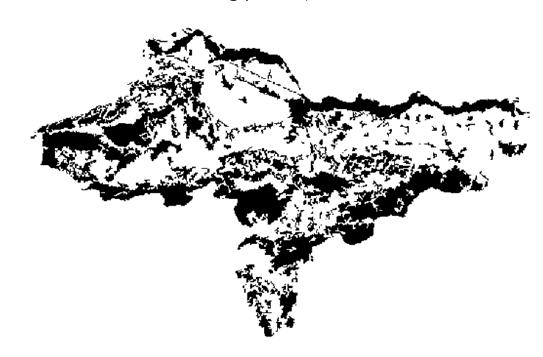
Figure 8 . Land cover suitable for panels installation (white areas)